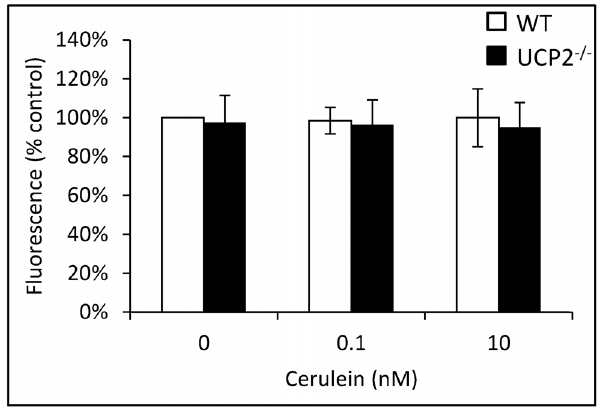
Figure 9. ROS levels in pancreatic acini isolated from WT and UCP2 -/- mice. DCFH-DA-labeled pancreatic acini of 12 months old WT and UCP2 -/- mice were treated in vitro with cerulein at the indicated concentrations for 30 min before fluorescence intensity of 2 9 ,7 9 - dichlorofluorescein was recorded. Data of 6 independent samples per experimental protocol were used to calculate mean values 6 SEM. * P , 0.05 (WT versus corresponding UCP2 -/- mice).